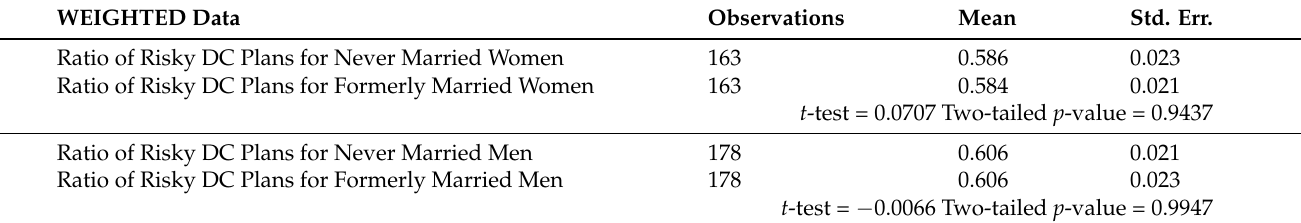
Table 9. Paired t -tests for Never Married and Formerly Married Individuals.